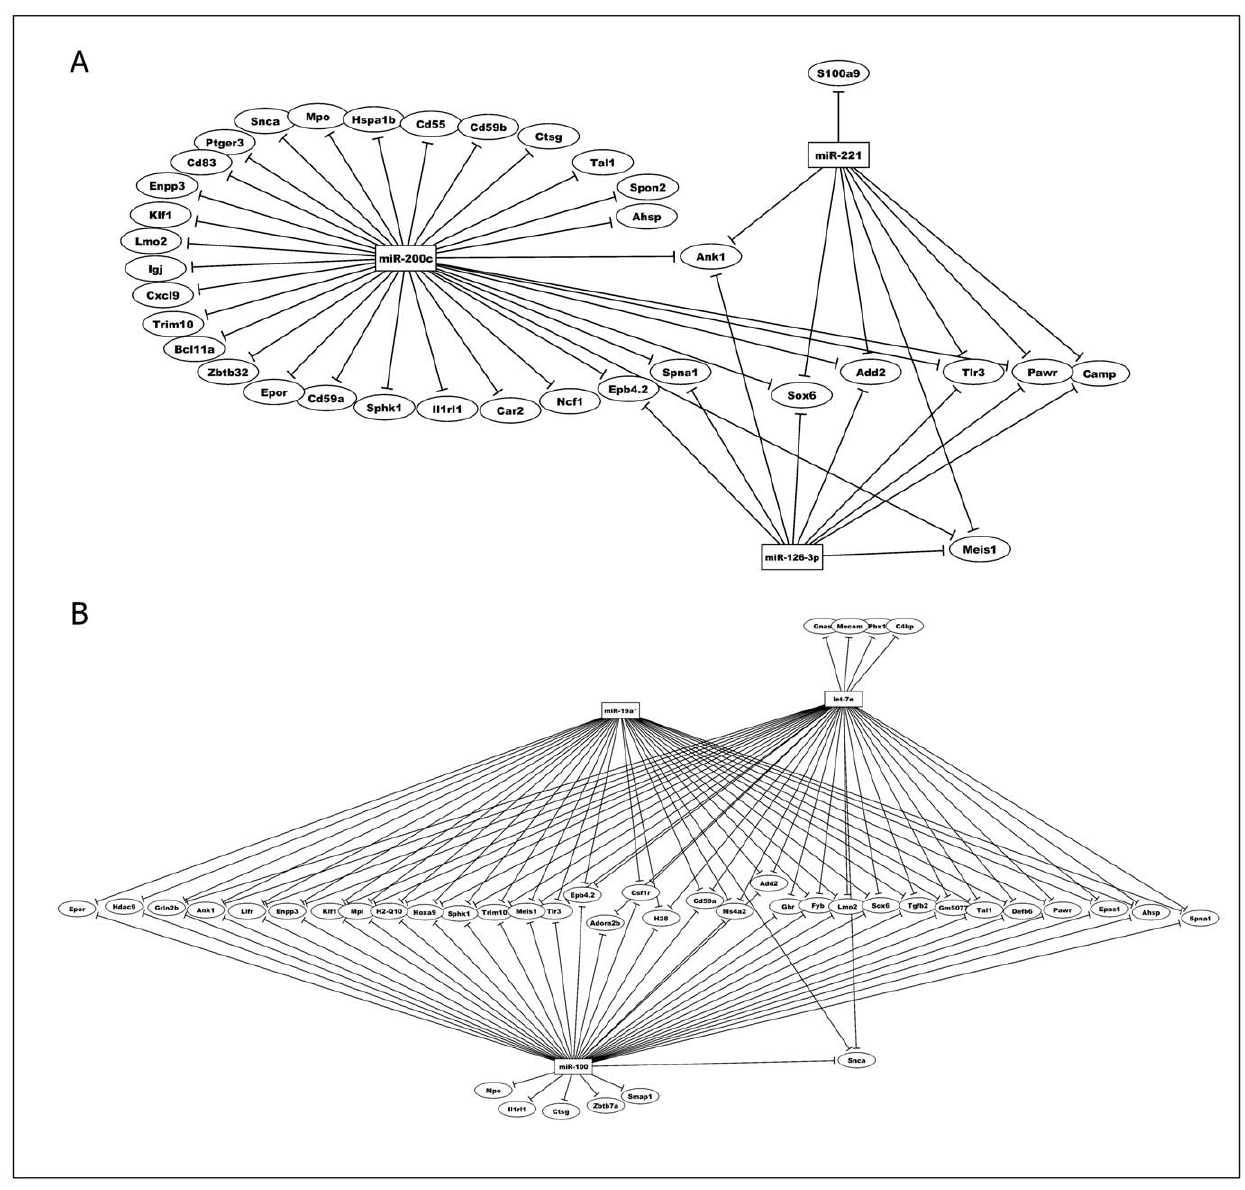
Figure 5. Post-transcriptional miRNA-mRNA interaction networks based on microarray expression data from thymocytes. The networks were obtained using the GenMir ++ algorithm. This figure shows the participation of A) three miRNAs up-regulated in thymocytes of DBA-1/ J strain and B) three miRNAs in up-regulated in thymocytes of DBA-2/J. These miRNAs interact with mRNAs related to immune system.